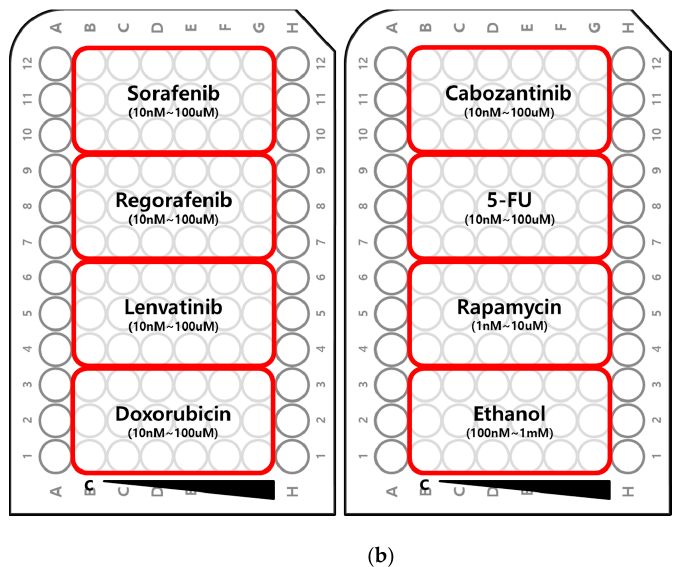
Figure 1. Schematic view of the pillar-based high-throughput myogenic differentiation assay. ( a ) A pillar strip was used to study inhibition of myogenic differentiation and ( b ) drug layout for the myogenic differentiation assay. Side wells were filled with PBS to prevent evaporating media during cell culture.